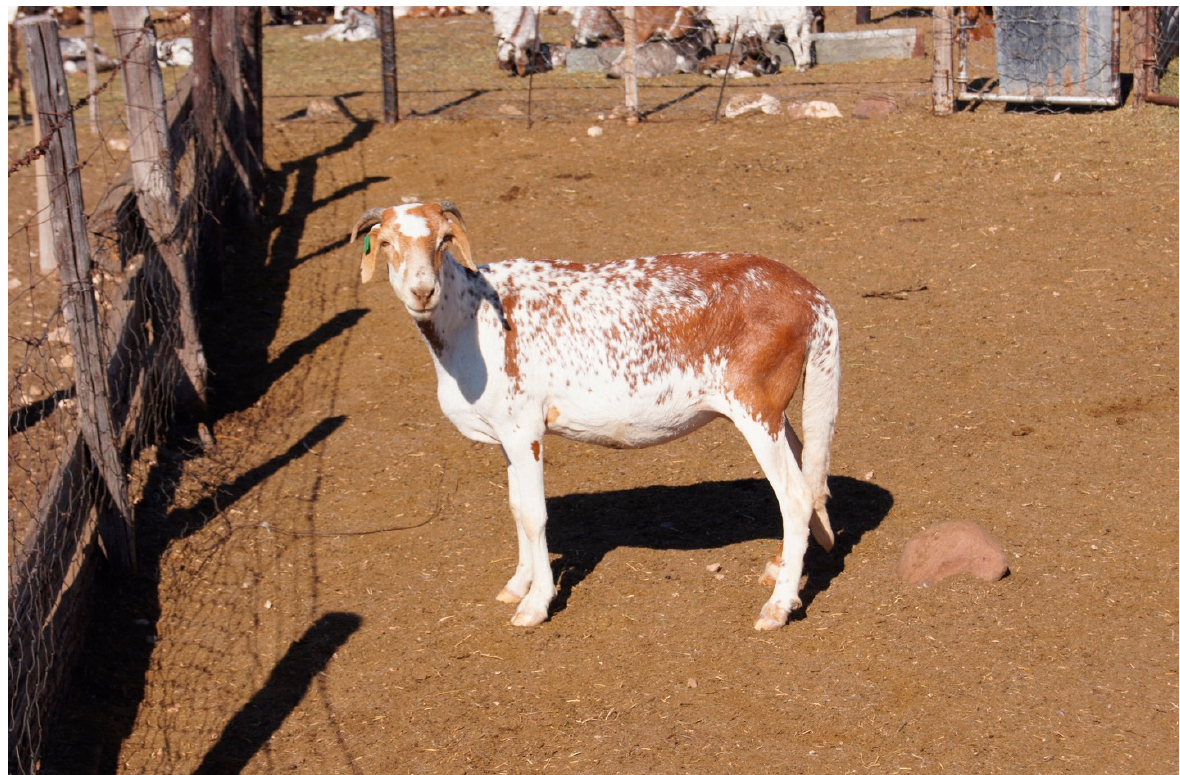
Figure 1. Damara sheep, specimen DAM25 (photograph credit: KAH).